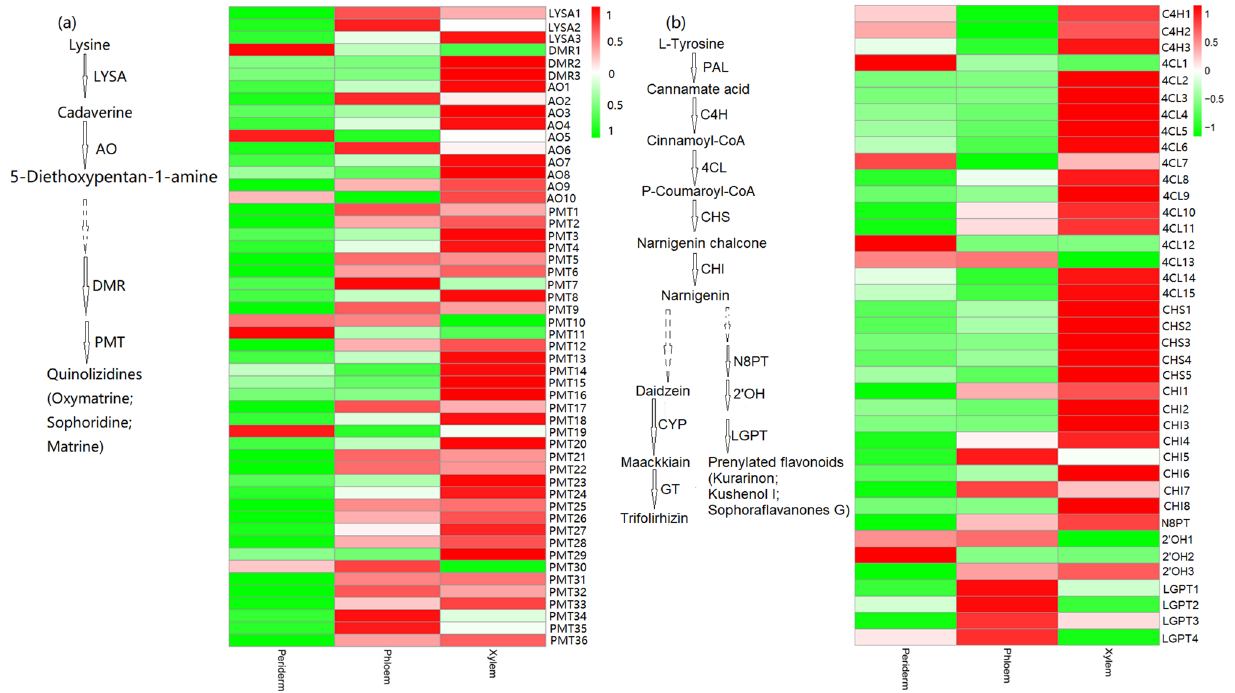
Figure 5. Heatmap of transcripts involved in the ( a ) alkaloid and ( b ) flavonoid biosyntheses in the roots of S. flavescens